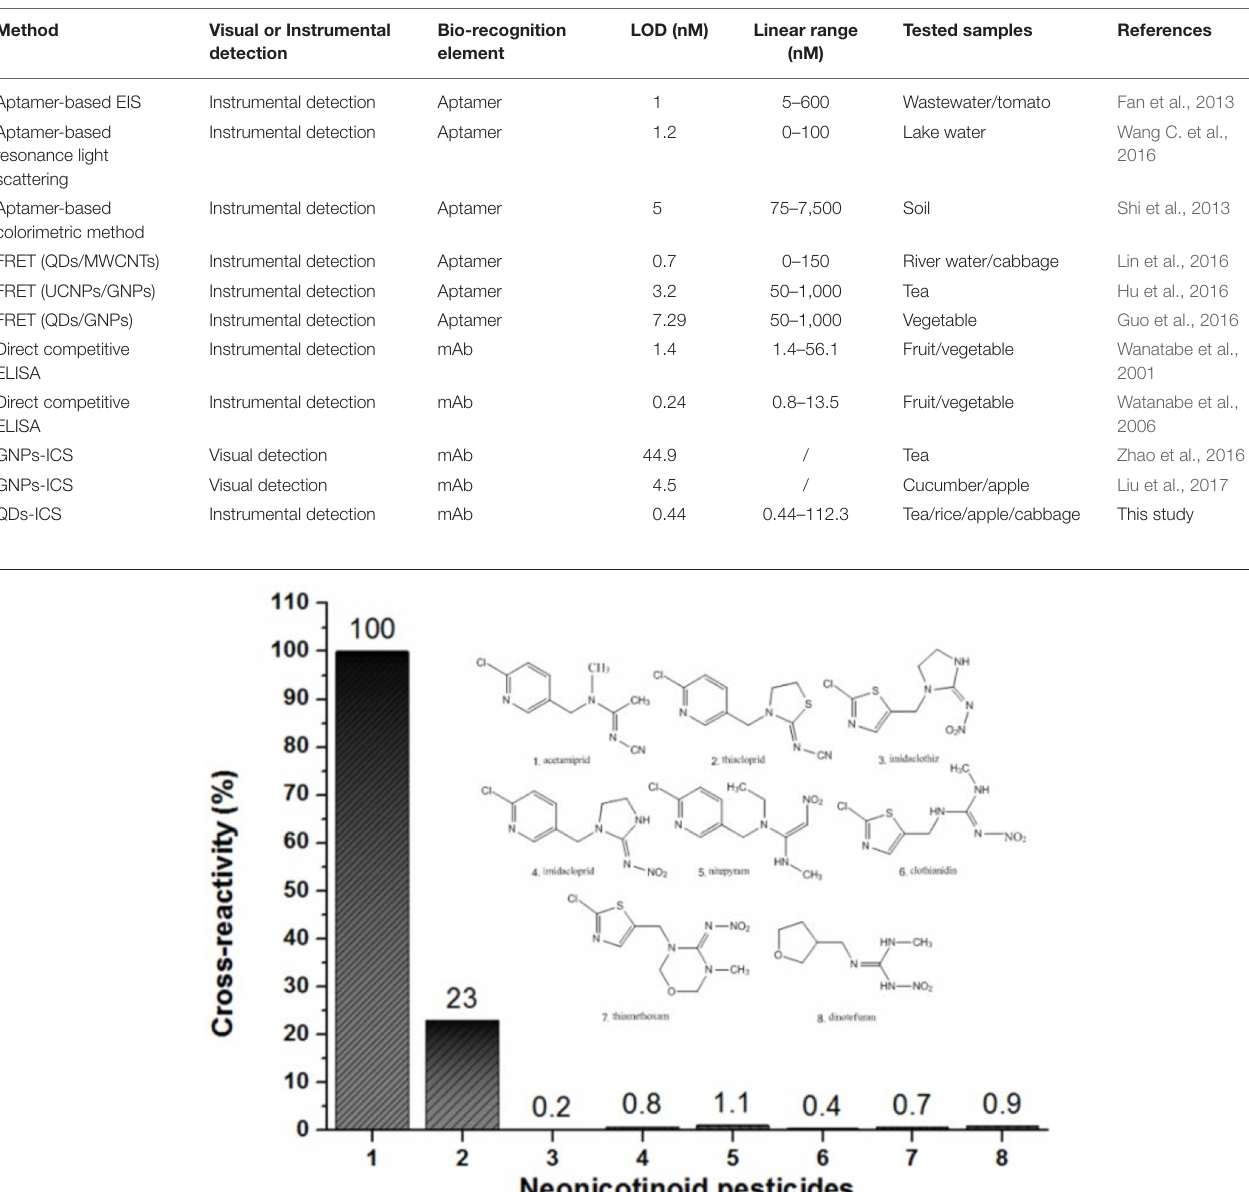
TABLE 2 | Comparison of the proposed ICS and other methods for acetamiprid detection in analytical performances. Method